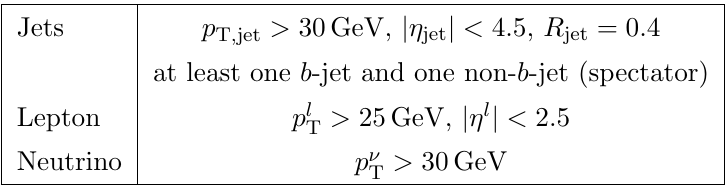
Table 1. Applied cuts at a center of momentum energy (cid:22) R = (cid:22) F set to DDIS scales. W -boson and top-quark reconstruction are as described in the